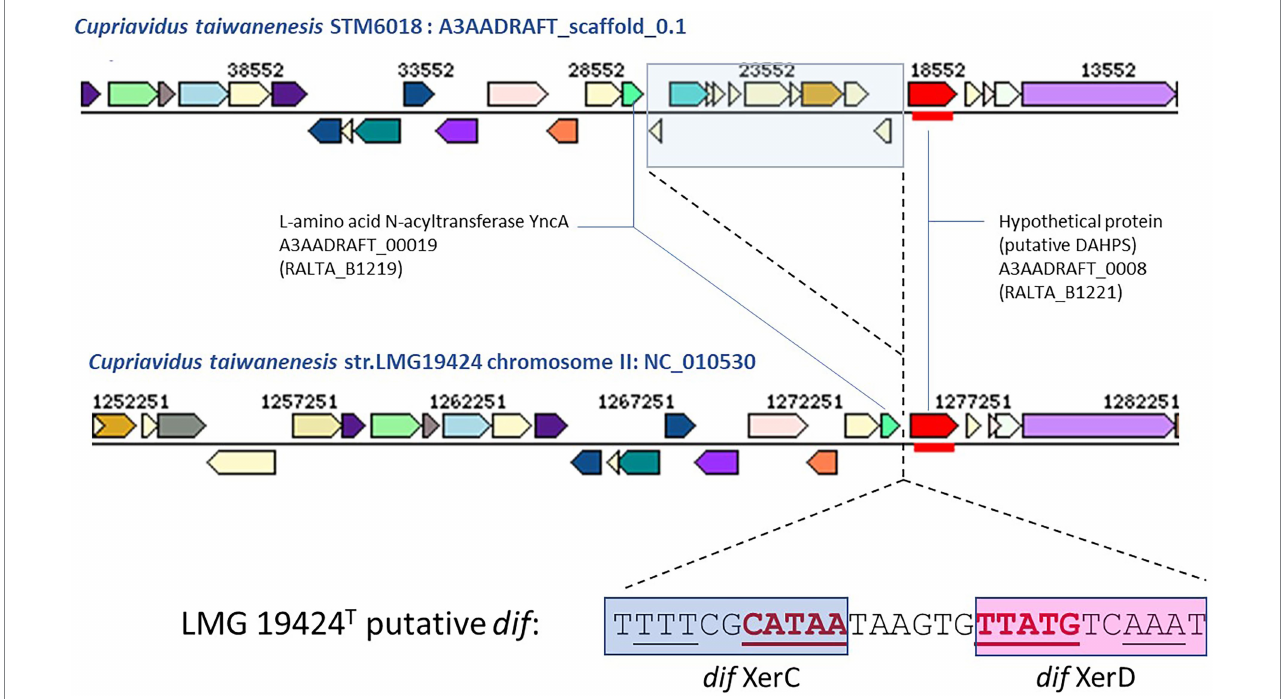
FIGURE 6 Comparison of the gene neighborhoods of Cupriavidus taiwanensis strains STM 6018 and LMG 19424 T showing the site of integration of the filamentous phage found in STM 6018 and the DNA sequence of the putative dif site and Xer binding sites. Xer binding sites were identified using the highly conserved XerD binding sites of closely related Ralstonia spp. reported by Carnoy and Roten